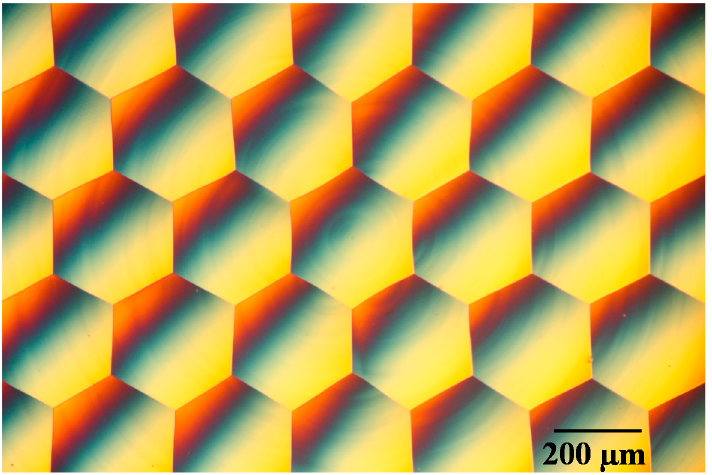
Figure 17. Differential interference contrast microscope image of the hexagonal microlens array.